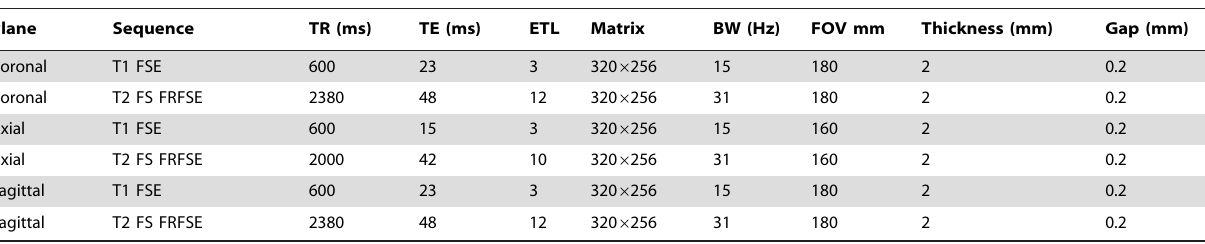
Table 1. Parameters of MRI sequences.